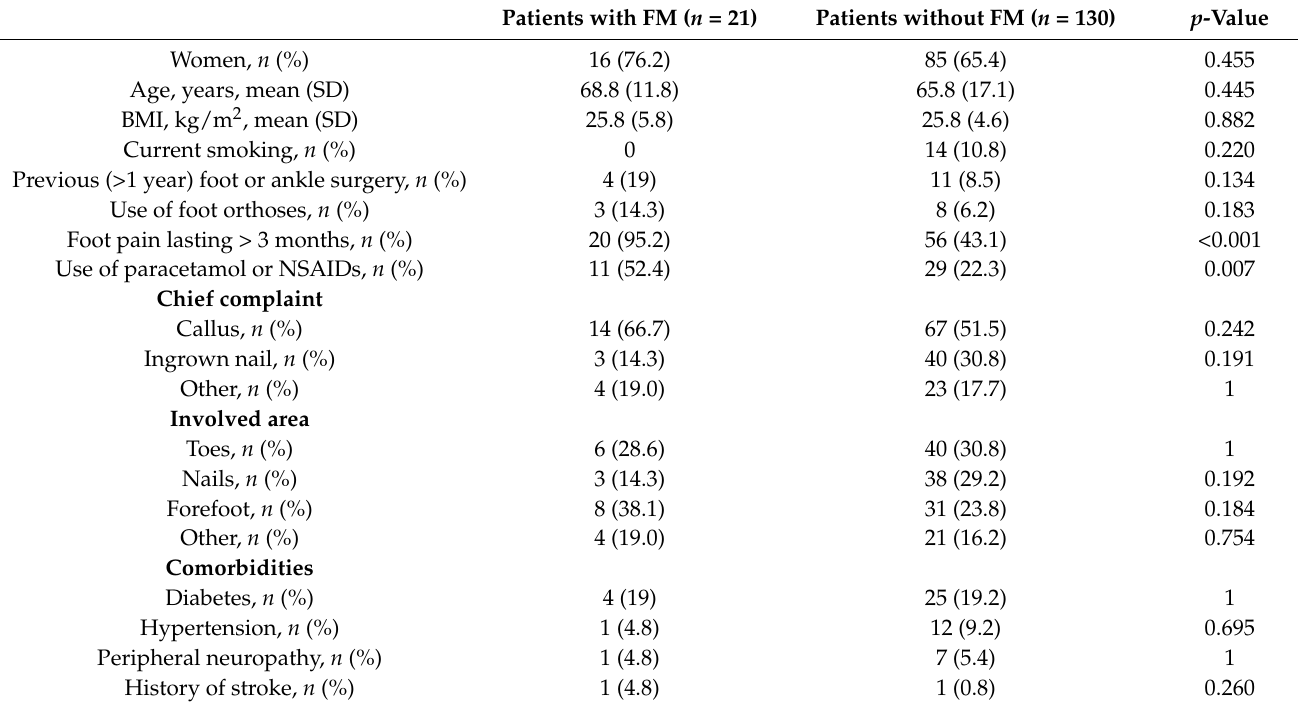
Table 2. Differences between patients with or without